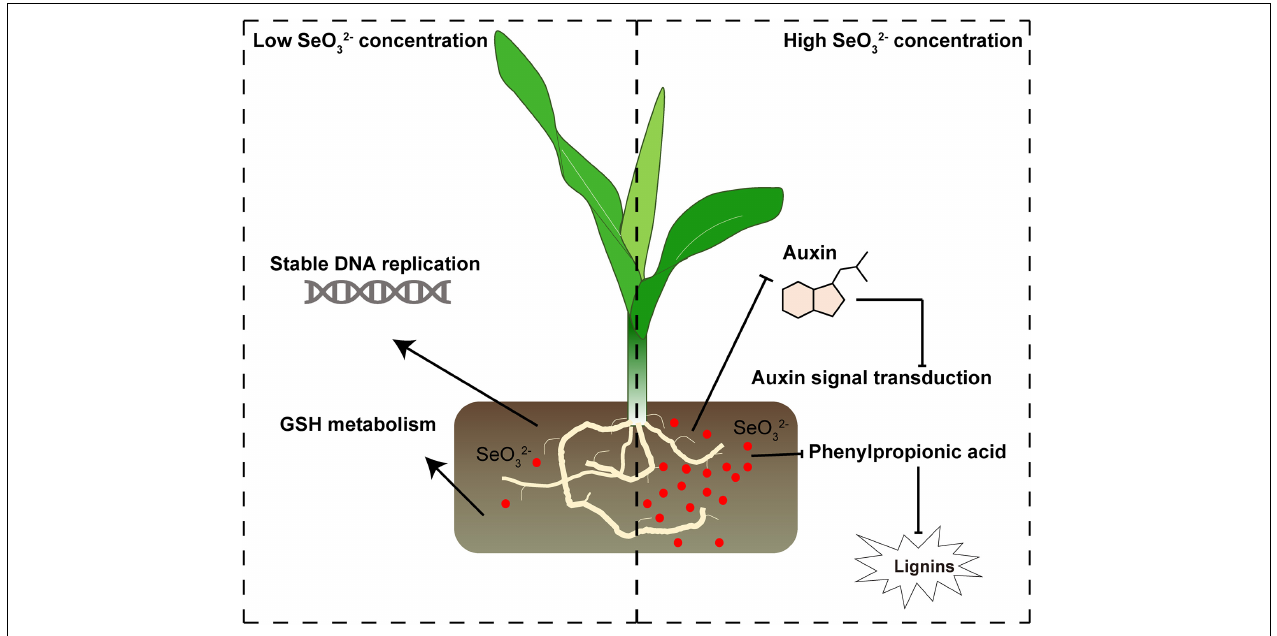
FIGURE 8 | The schematic diagram for the mechanisms of low and high Se treatment effects on maize seedling growth. Se potentially promotes maize seedling growth by stabilizing DNA replication and GSH metabolism; the high doses of Se may have inhibited auxin signal transduction and lignin biosynthesis, reducing maize growth. Red circles represent SeO 32 − . Arrows and inhibition lines represent the activation and suppression processes,